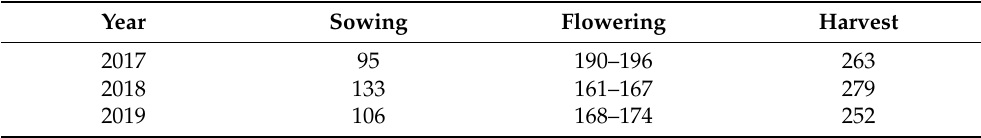
Figure 1. ( a ) Illustration of the experimental maize breeding field; ( b ) detail of the infrared ther- mometer (model IR120, Campbell Scientific Ltd., Shepshed, UK) installed on a well-watered maize plot; ( c ) detail of the infrared thermometer (model MI-230, Apogee Instruments Ltd., Logan, UT, USA) used for manual T c measurements. Table 1. Crop development dates (expressed in days of the year, DOY) during the three experimental growing cycles.